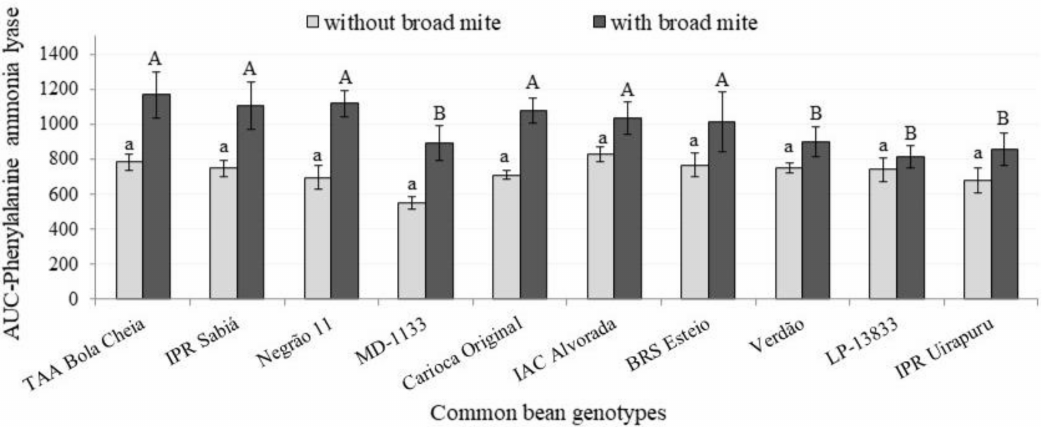
Figure 5. Area under the curve of phenylalanine ammonia lyase content in leaves from different common bean genotypes infested (dark column) and not infested (clear column) with Polyphagotarsonemus latus . Values obtained from assessments one day before and 1, 2, 6, 8, 10, 13 and 15 days after P. latus infestation. Columns with the same letter, lower case (a, b) for “without broad mite” and capital letters (A, B) for “with broad mite”, do not differ by Scott–Knott test ( α =